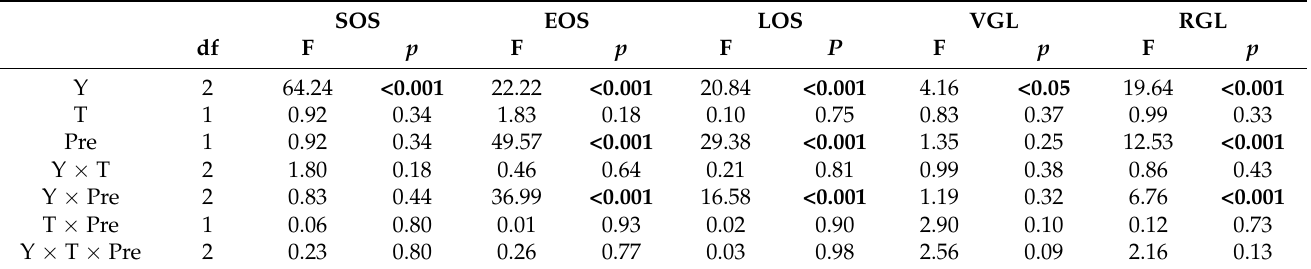
Note: SOS represents the start of the growing season; EOS represents the end of the growing season; LOS represents the length of growing season; VGL represents vegetative growth length; RGL represents reproductive growth length. The values of p < 0.05 are bolded.